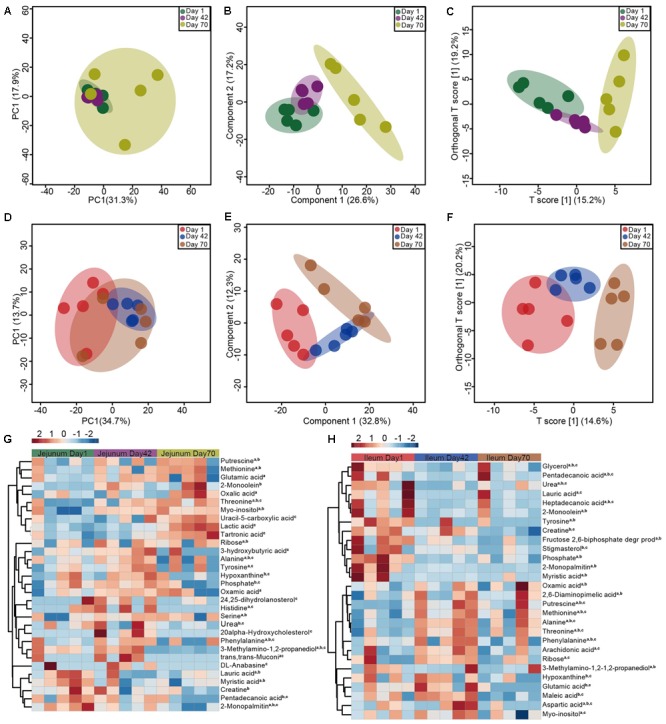
The jejunum and ileum metabolome of sika deer at days 1, 42, and 70. Principal component analysis (PCA), partial least squares discriminant analysis (PLSDA) and orthogonal partial least-squares discriminant (OPLS-DA) analysis revealing the metabolites variation in jejunum (A–C) and ileum (D–F), respectively. Heat-map showing the significantly increased or decreased metabolites in jejunum (G) and ileum (H), respectively. a, b, c indicate the significance between days 1 and 42, between days 42 and 70, and days 42 and 70, respectively.